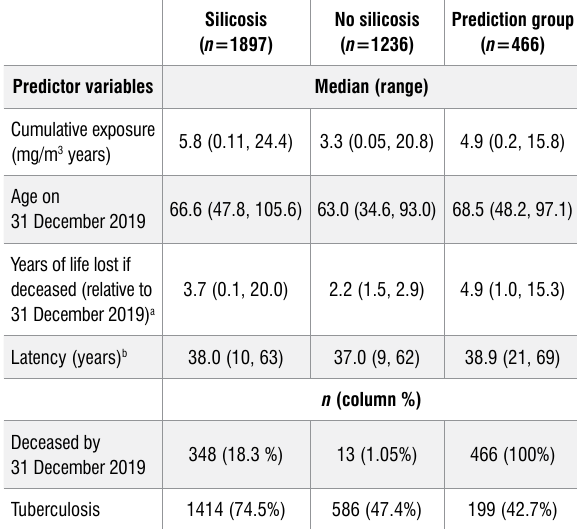
Characteristics of claimants in the Modelling (by silicosis diagnosis) and Prediction groups Silicosis ( n =1897) Predictor variables Median (range)